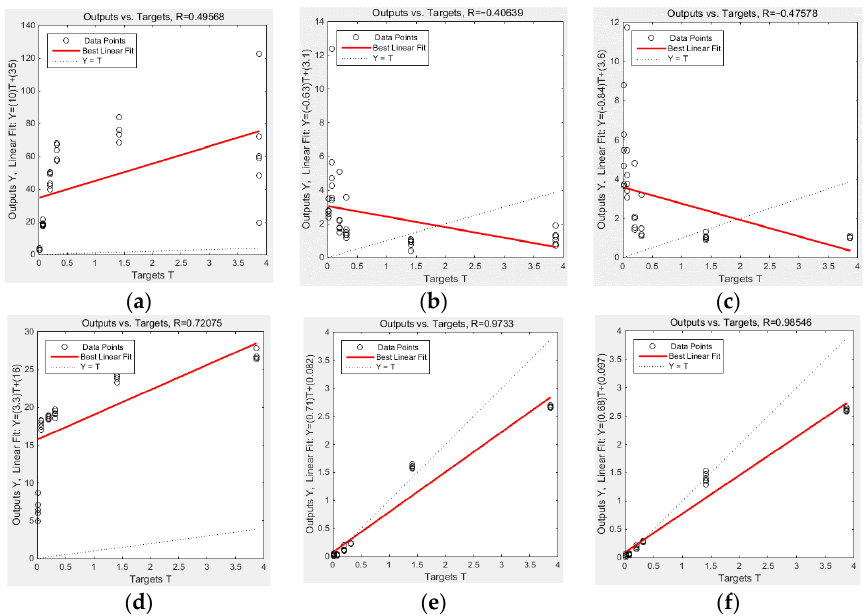
Figure 8. Fitting results of evaluated values and true values for each method. The X-axis represents the true values, and the Y-axis represents the estimated values. “ ○ ” represents the input data. The red solid lines are the ideal fitting results. Additionally, R is the correlation coefficient between the estimated values and the true values. The closer R is to 1.0, the higher the correlation. The closer the estimated values are to the true values, the better the performance of the method: ( a ) LSD; ( b ) FFT-DC; ( c ) ReSNR; ( d ) DnCNN; ( e ) Net-1; and ( f ) Net-2-M.